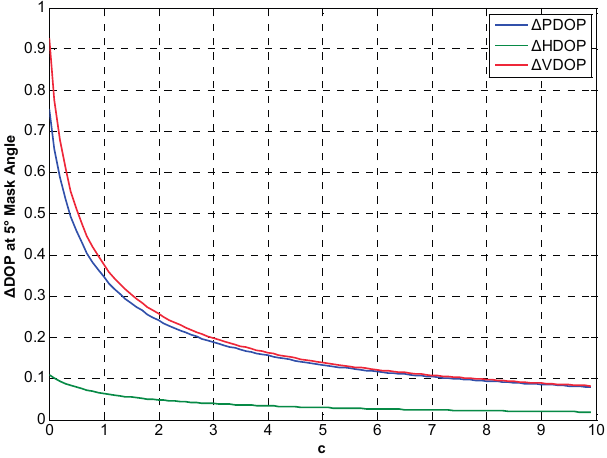
Figure 14. Δ DOP with different c at 5° cutoff